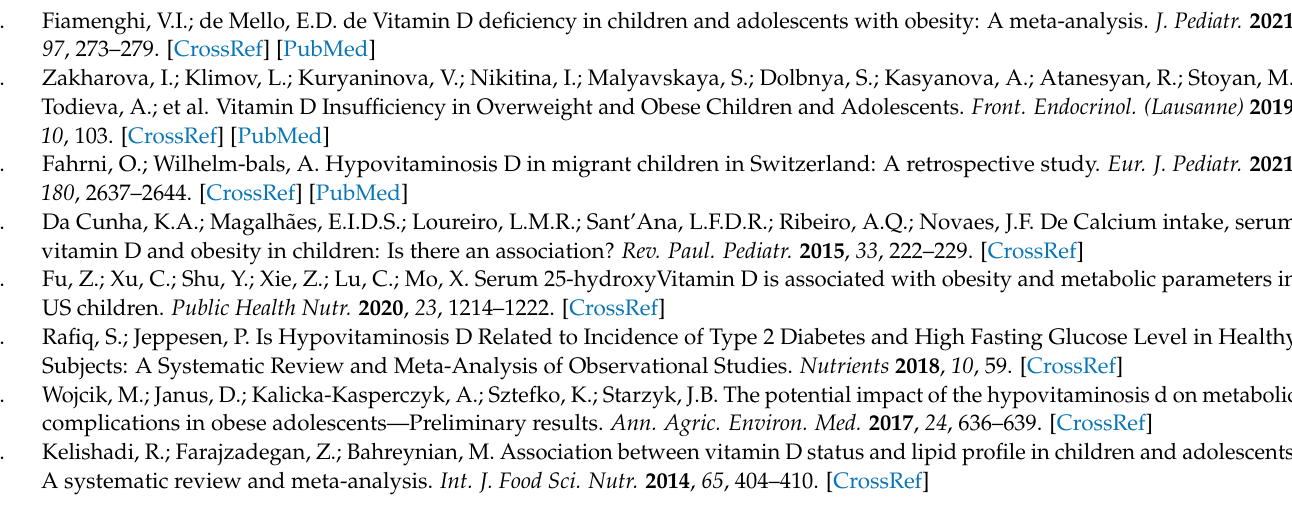
Table S2: Characteristics of participants according to vitamin D status; Table S3: Results of the multivariate analysis of the factors associated with hypovitaminosis